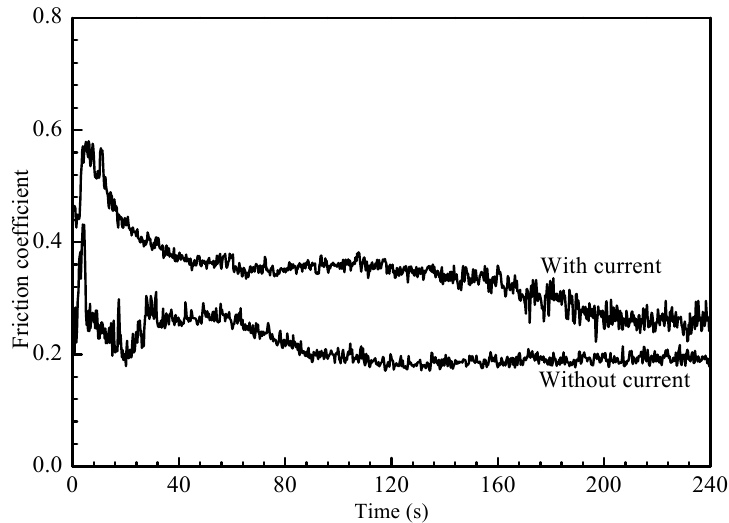
Figure 14. Friction coefficient curve under the condition of being with or without current.